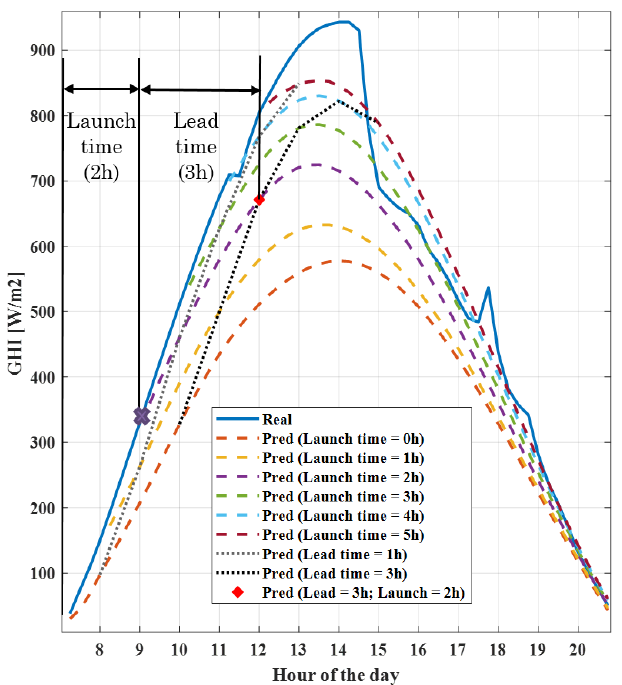
Figure 6. Real measurements of a selected day and its predictions. Dashed lines are the predictions for different launch times and dotted lines correspond to different lead times. Both parameters can be specified for a single day, obtaining the point forecast plotted with a red diamond.